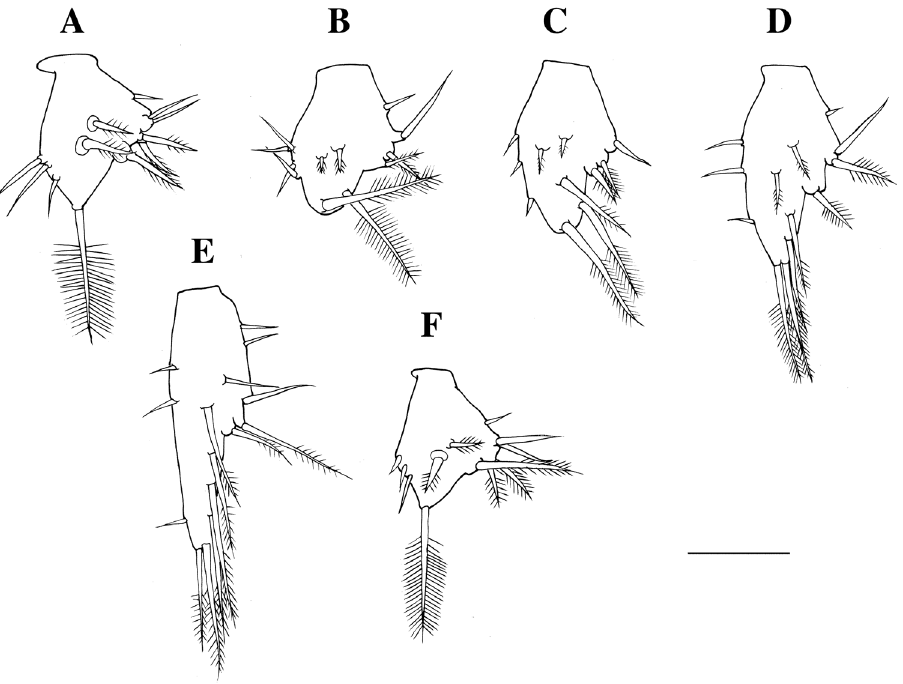
Figure 5. Mysidella hoshinoi sp. n., A–E holotype male F paratype female (KMNH IvR 500894): A left first pleopod, ventral B left second pleopod, ventral C left third pleopod, ventral D left fourth pleopod, ventral E left fifth pleopod, ventral F left first pleopod, ventral. Scale bar 100